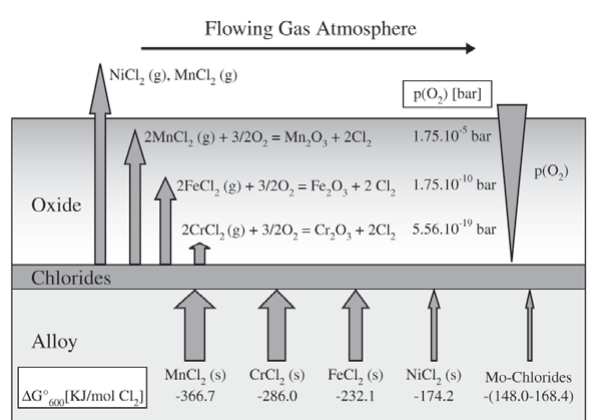
Figure 5. Schematic of thermodynamics and reactions in the cor- rosion of the alloying elements Mn, Cr, Fe, Ni and Mo in a flowing oxidizing and chloridizing